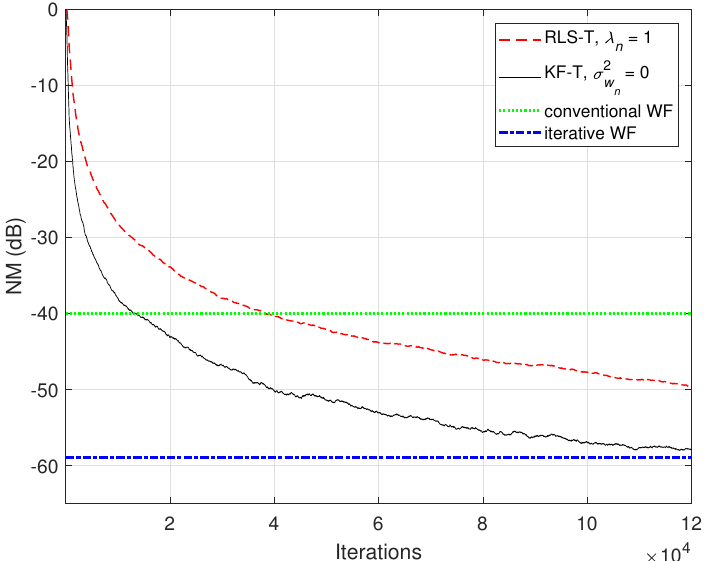
Figure 4. Normalized misalignment (NM) of the RLS-T algorithm using λ n = 1, n = 1,2, . . . , N , = 0, n = 1,2, . . . , N , and the conventional and iterative WFs [38], for the the KF-T using σ 2 w n identification of the global impulse response, h ( t ) .